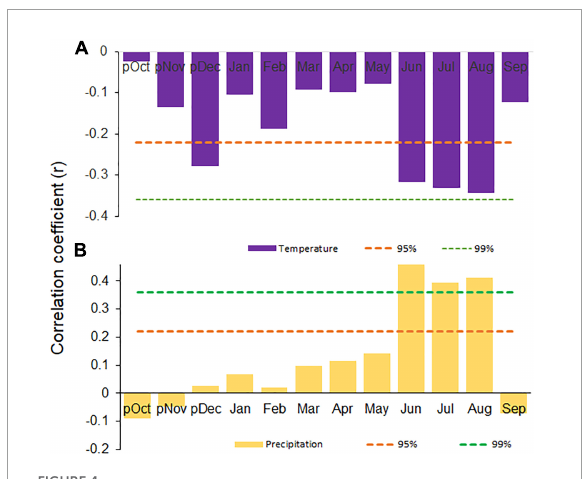
this chronology for climate reconstruction. The EPS value > 0.85